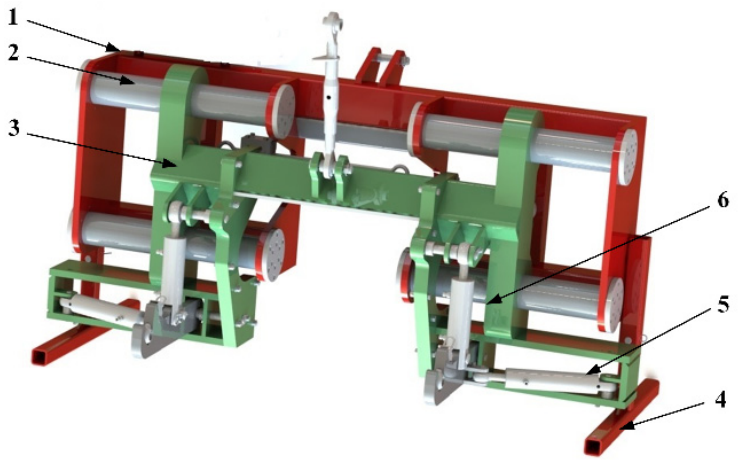
Figure 5. Side-shift mechanism. Note: 1, Front passive frame; 2, Double circular axle; 3, Rear active frame; 4, Foot rest; 5, Lateral adjustment mechanism; 6, Longitudinal adjustment mechanism.